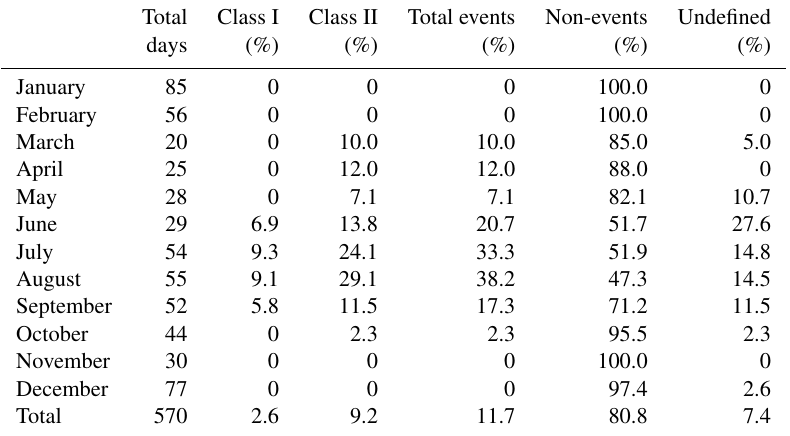
Table 3. Percentage of total new particle formation events (marked in blue) vs. non-events and undefined days during the period July 2010 to February 2013. The total events were further divided into class I and class II events. A column of total days (by month) over the studied years was also provided. Total Class I Class II Total events (%)